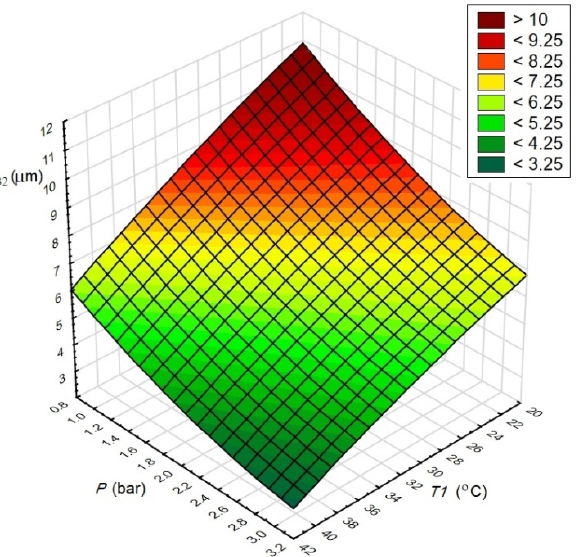
Figure 6. Dependence between the mean volume–surface diameter (Sauter) and gas pressure, and temperature of gas.